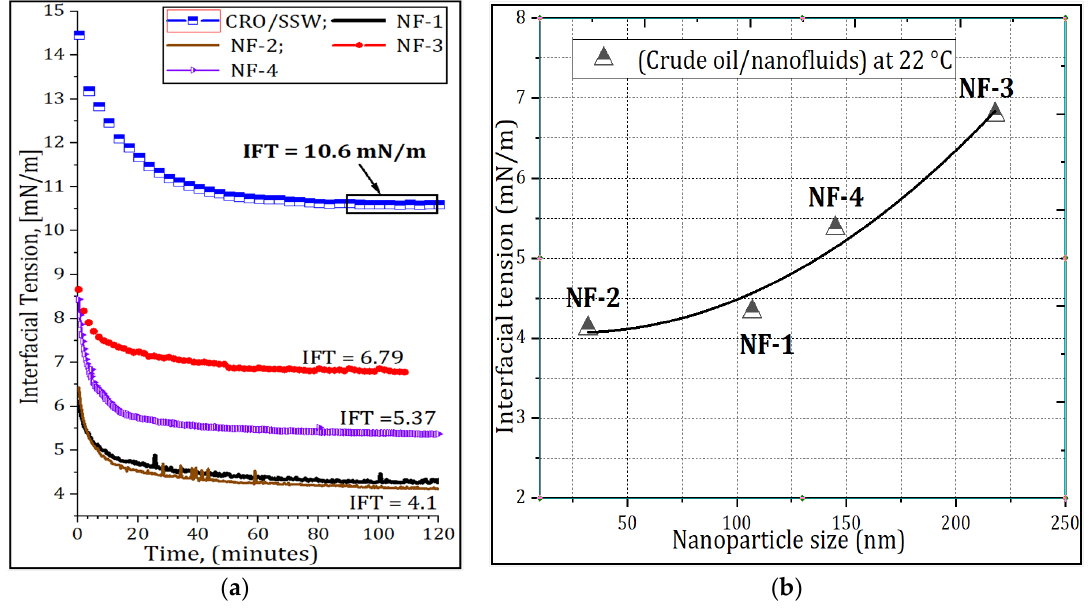
Figure 6. ( a ) Dynamic measurement of interfacial tension (IFT) between crude oil (CRO) and nanofluids, and ( b ) variation of IFT with nanoparticles’ size.